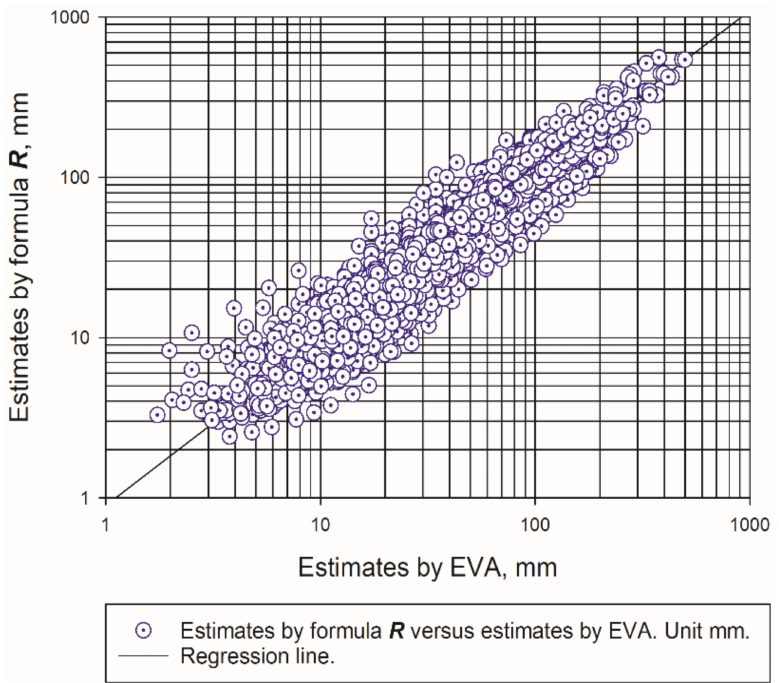
Figure 4. Dataset R1 for the development of the relationship R . This dataset consists of 70 locations and with 4132 pairs of estimated and corresponding EVA values.